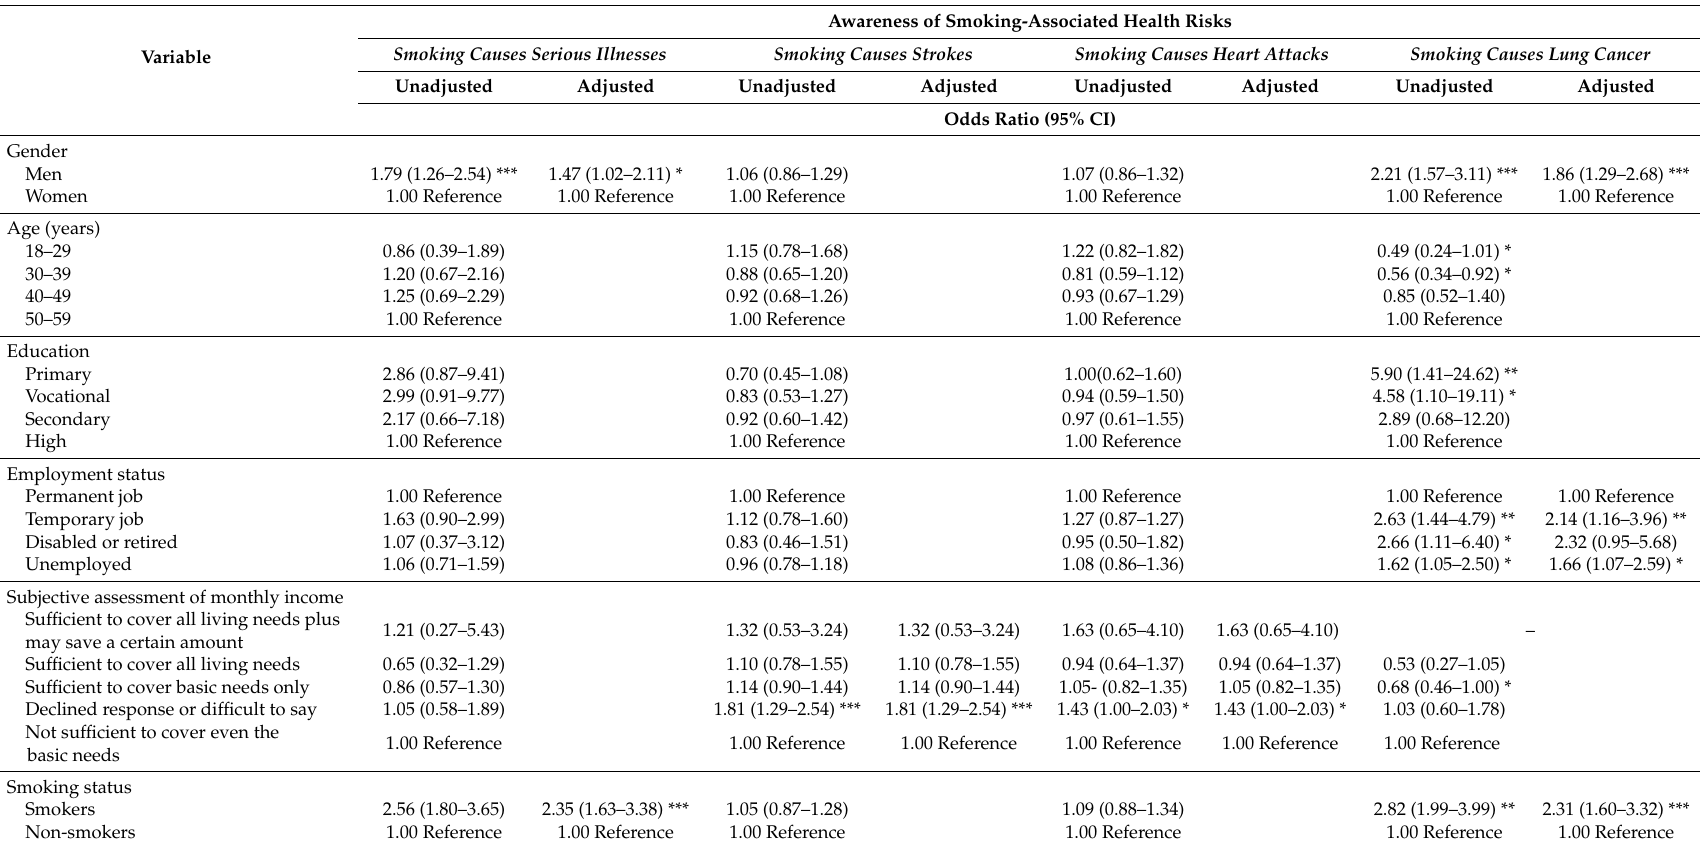
Table 1. Lack of awareness of smoking-associated health risks among the study respondents n =